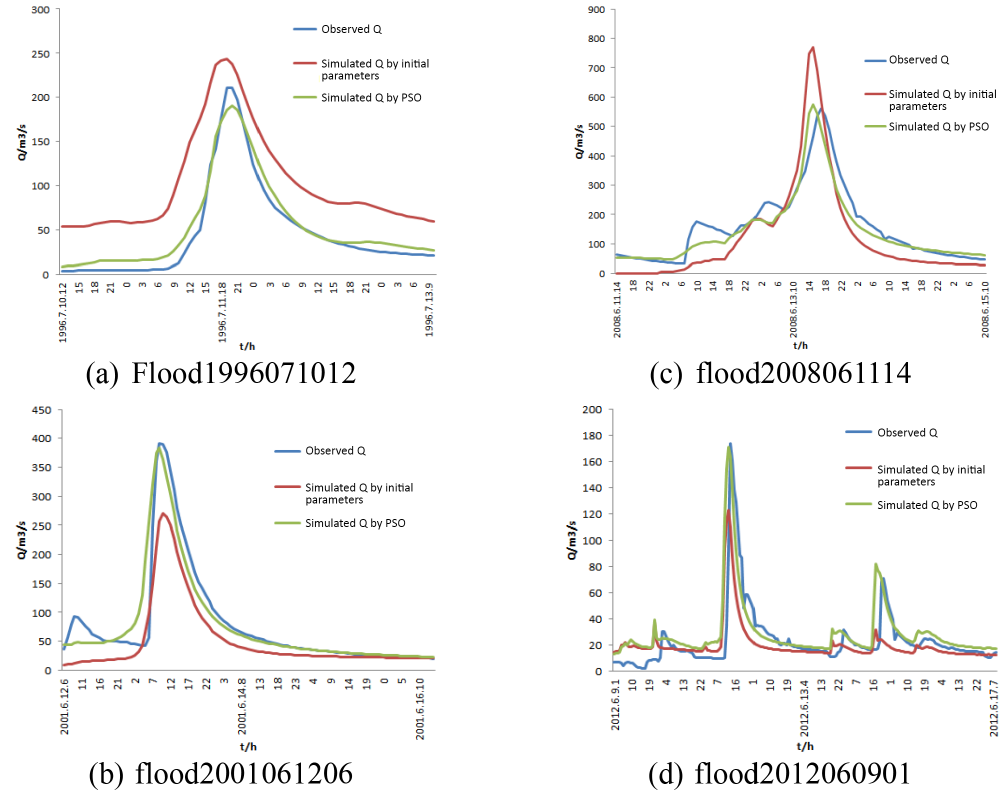
Figure 7. Simulated flood events of Tiantoushui Catchmen. (a) flood1996071012, (b) flood2001061206, (c) flood2008061114, (d)